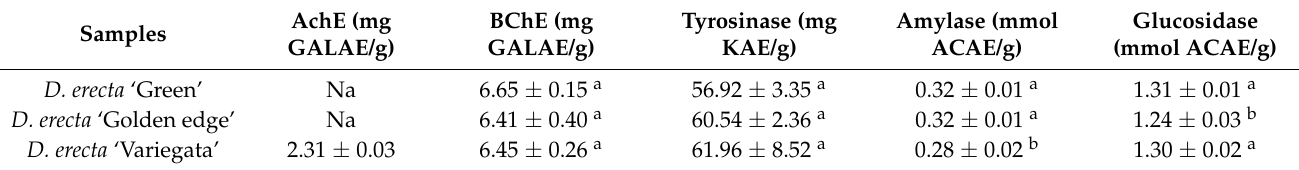
Table 4. Enzyme inhibitory properties of the tested oils.